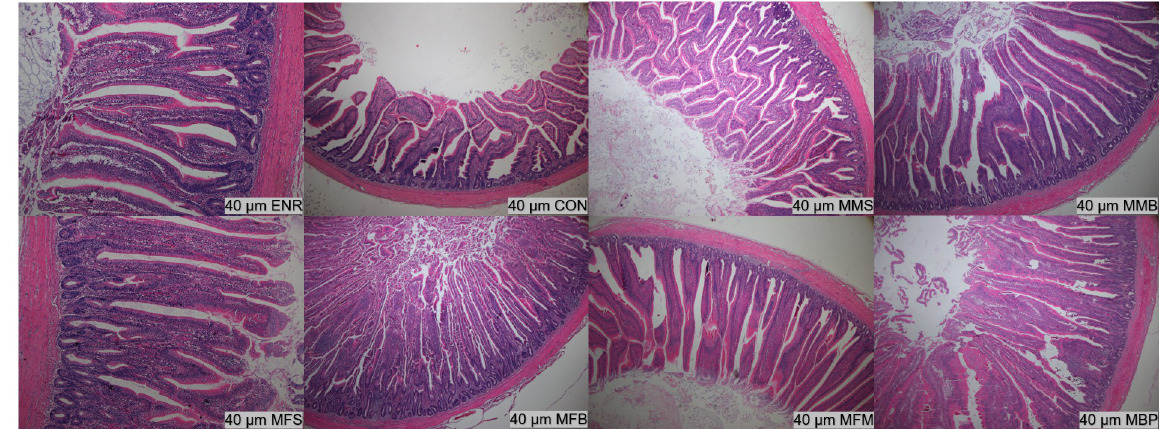
Fig 3. Histological structure of Hematoxylin and Eosin (H&E) staining jejunum at 42 day of age. CON, control diet; ENR; CON + 100 mg/kg ENR, MMS; CON + 2000 mg/kg MOS + 300 mg/kg MAN + 1500 mg/kg SB, MMB; CON + 2000 mg/kg MOS + 300 mg/kg MAN + 500 mg/kg BS, MFS; CON + 2000 mg/kg MOS + 9000 mg/kg FOS + 1500 mg/kg SB, MFB; CON + 2000 mg/kg MOS + 9000 mg/kg FOS + 500 mg/kg BS, MFM; CON + 2000 mg/kg MOS + 9000 mg/kg FOS + 300 mg/kg MAN, MBP; CON + 2000 mg/kg MOS + 500 mg/kg BS + 37 mg/kg PT. SB; Sodium butyrate, FOS; Fructose oligosaccharide, PT; Phytase, BS; Bacillus subtilis, MOS; Mannose oligosaccharide, MAN; Mannanase.